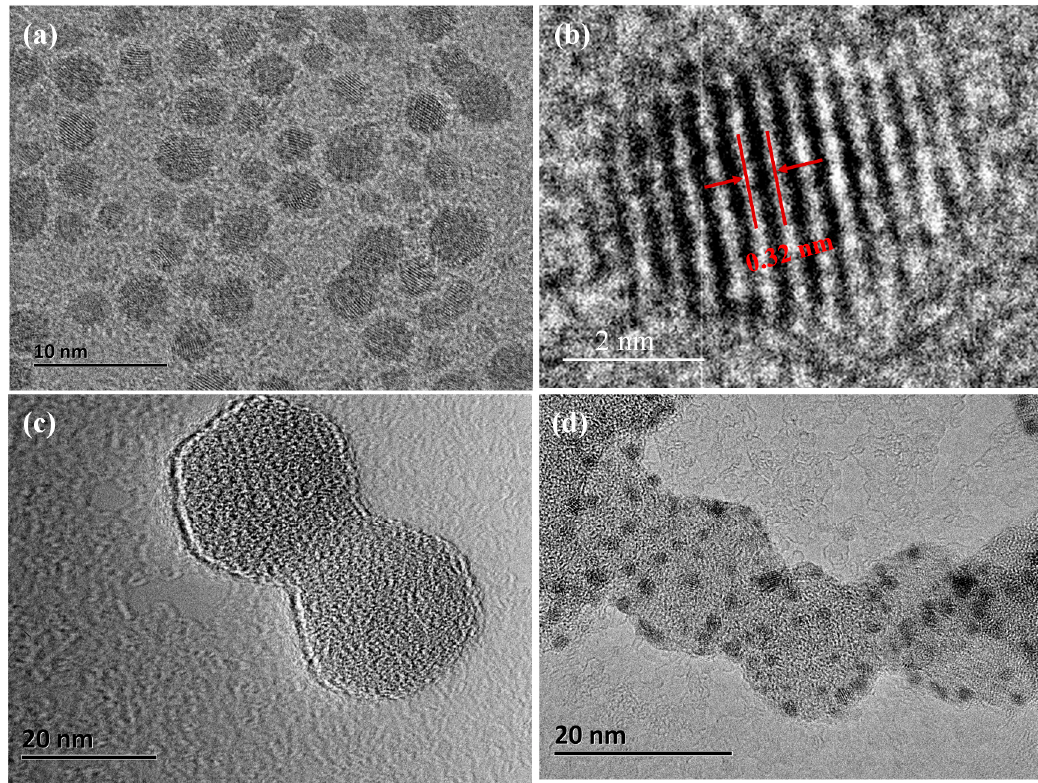
Figure 2. TEM images of ( a ) spherical CDs, ( b ) high-resolution TEM (HRTEM) image of the CDs, ( c ) ZIF-8 nanocrystals, and ( d ) Au@ZIF-8